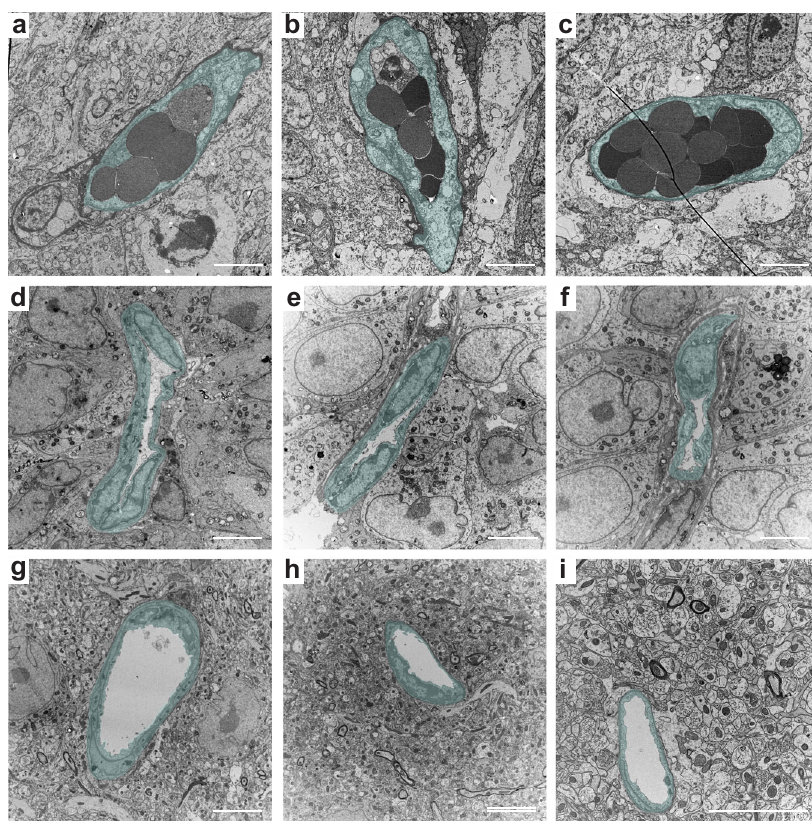
Fig. 1 Ultrastructural examination of GBM vasculature suggesting incomplete transcardial perfusion. Transmission electron microscopy imaging of erythrocytes remaining in GBM vessel lumens after transcardial perfusion ( a – c ), compressed vessel lumens in GBM ( d – f ), and the lumens of normal brain capillaries from the contralateral hemisphere ( g – i ). Cells composing vessel walls are highlighted with semitransparent cyan. Scale bars, 5 µ